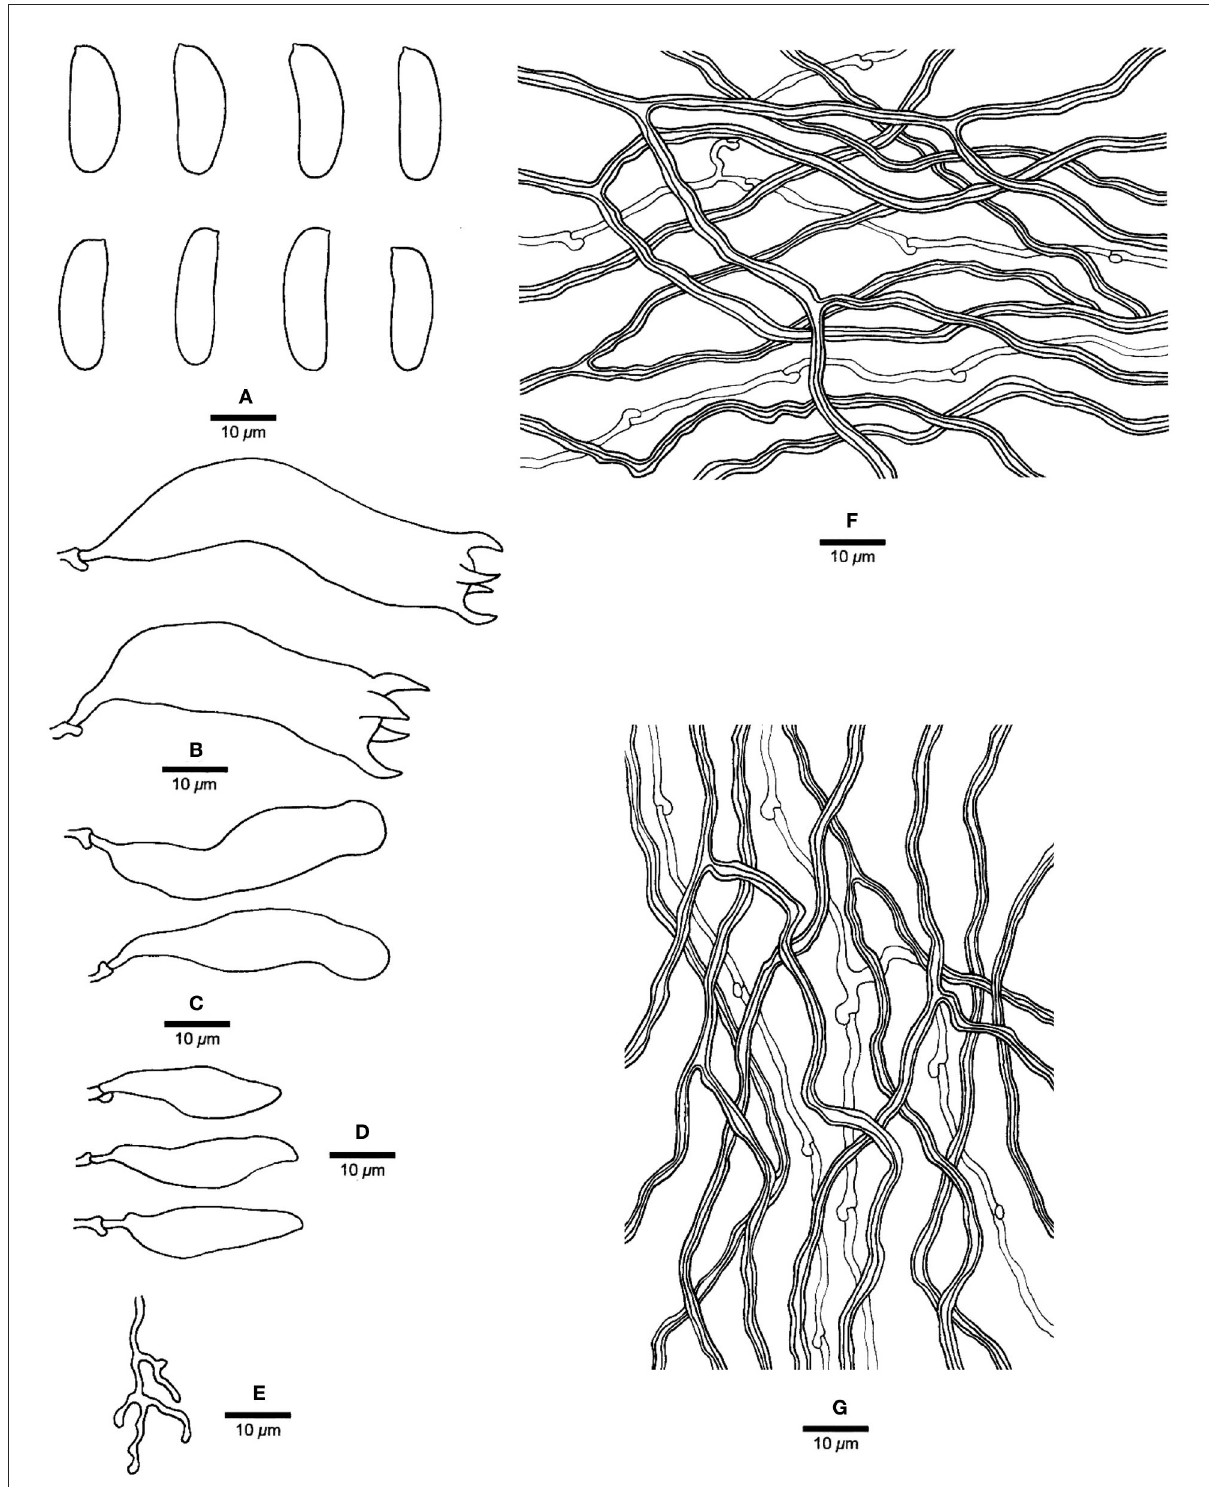
FIGURE5 Microscopic structures of Jorgewrightia irregularis (drawn from holotype, Dai 13853). (A) basidiospores, (B) basidia, (C) basidioles, (D) cystidioles, (E) dendrohyphidia, (F) hyphae from subiculum, and (G) hyphae from tube